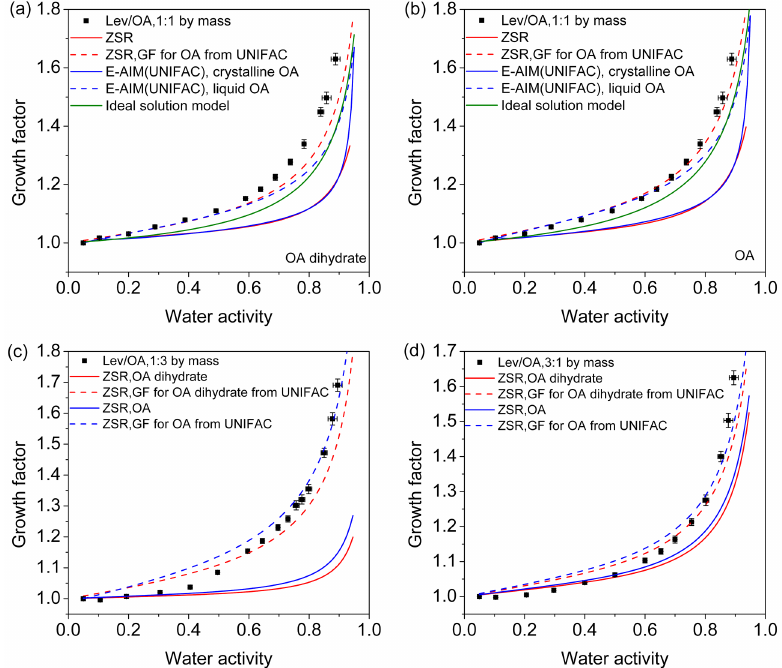
Figure 3. Hygroscopic growth factors of aerosols containing levoglucosan and oxalic acid (Lev / OA) with various mass ratio (a) and (b) 1:1, (c) 1:3, (d) 3:1 as a function of water activity. Initial particle diameter is about 100nm. Predictions from the ZSR, E-AIM (UNIFAC), and ideal solution model are included in (a) and (b) , assuming oxalic acid dihydrate and anhydrous oxalic acid in the initial particles under dry conditions, respectively. The dashed lines are calculated based on liquid oxalic acid (OA) assumption. For (c) 1:3, (d) 3:1 mass ratio, only ZSR-predicted curves are shown on the basis of different OA assumption. The uncertainty in our measured growth factors is within